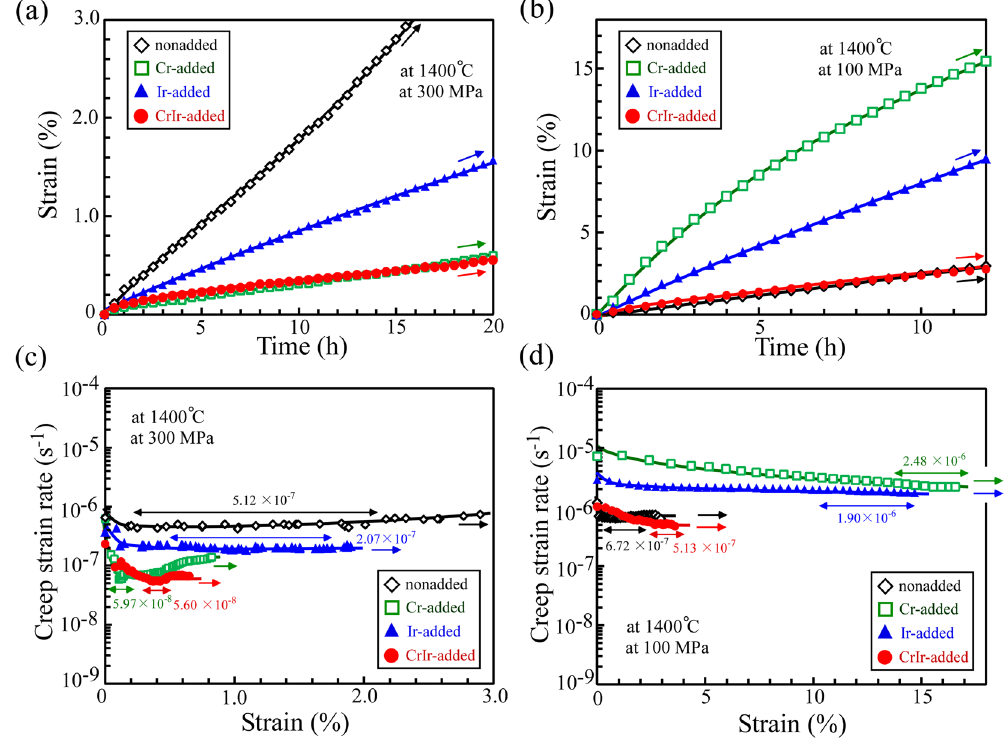
Figure 3. Compressive creep-deformation curves of the various (Mo 0.85 Nb 0.15 )Si 2 -based two-phase crystals at 1400 °C. ( a ) Creep strain versus time curves in the 0° orientation at 300 MPa and ( b ) in the 45° orientation at 100 MPa. ( c , d ) Corresponding creep strain rate versus strain curves for Figs. ( a , b ),